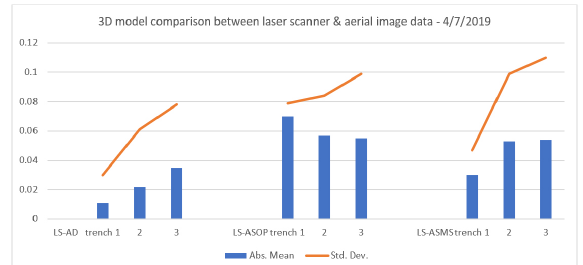
Chart 1 . 3D model comparison between laser scanner and aerial image data during the first day of the fieldwork